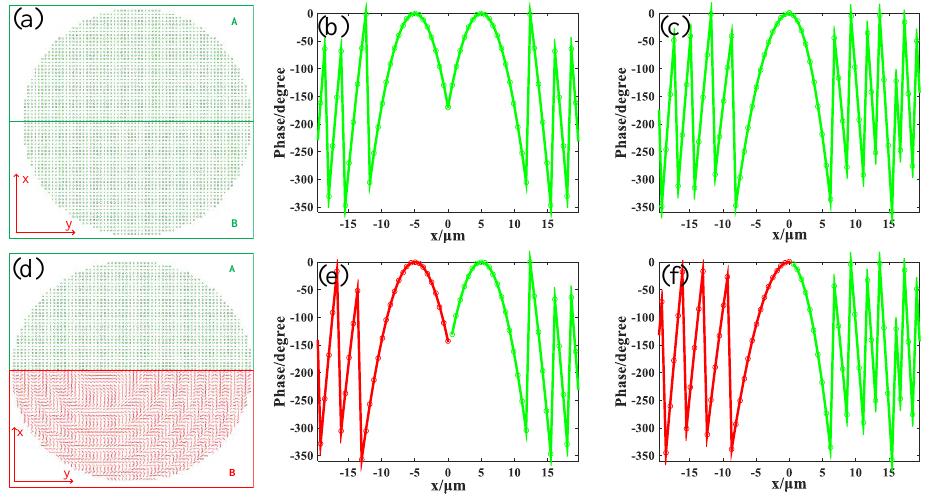
Figure 3. ( a ) The layout of the single wavelength tunable duplex metalens (M 1 , M 2 ). The metalens is divided into two equal sections A and B, composed of unit cells U 1 . ( b ) The phase profile of metalens M 1 along the x axis while y = 0, the central position of the metalens is at (0, 0). ( c ), ( e ) and, ( f ) adhere to the same conditions. ( c ) The phase profile of metalens M 2 . ( d ) The layout of the dual wavelength tunable duplex metalens (M 3 , M 4 ). Section A is constructed with unit cells U 1 and section B is constructed with unit cells U 2 . ( e ) The phase profile of metalens M 3 . ( f ) The phase profile of metalens M 4 .